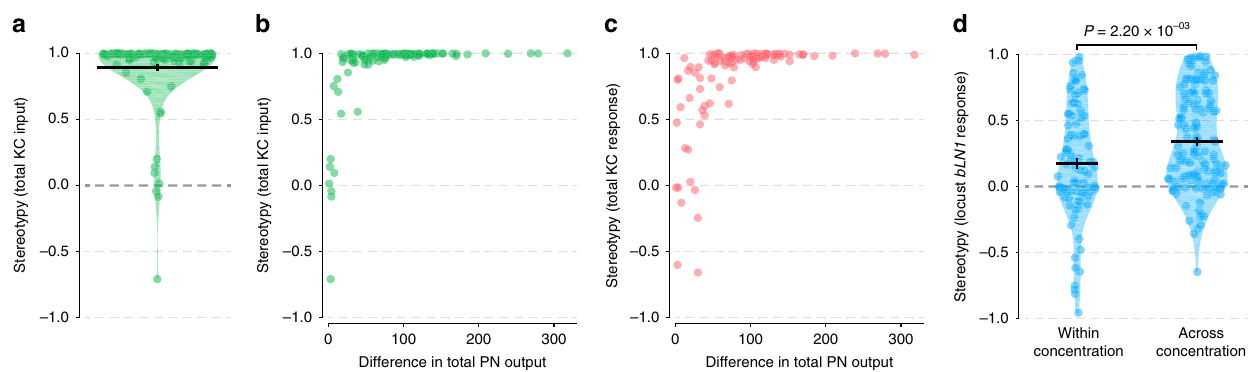
Fig. 4 Difference in input drives affects stereotypy. a Stereotypy in total KC input in the simulations. PRED metric was used for calculation of stereotypy in these and all subsequent analyses. b , c Scatter plots of stereotypy in total KC input ( b ) or total KC response ( c ) versus the difference in total PN outputs between the two odors. a – c Each point represents a network iteration ( n = 100). d Stereotypy in locust bLN1 responses is more for the across- concentration group than the within-concentration group. The within-concentration group has n = 90 stereotypy values (15 pairs of individuals × 3 pairs of odors × 2 concentration levels) and the across-concentration group has n = 135 stereotypy values (15 pairs of individuals × 9 pairs of odors such that one odor in the pair is at 0.1% concentration and the other odor is at 10% concentration). In a , d error bars